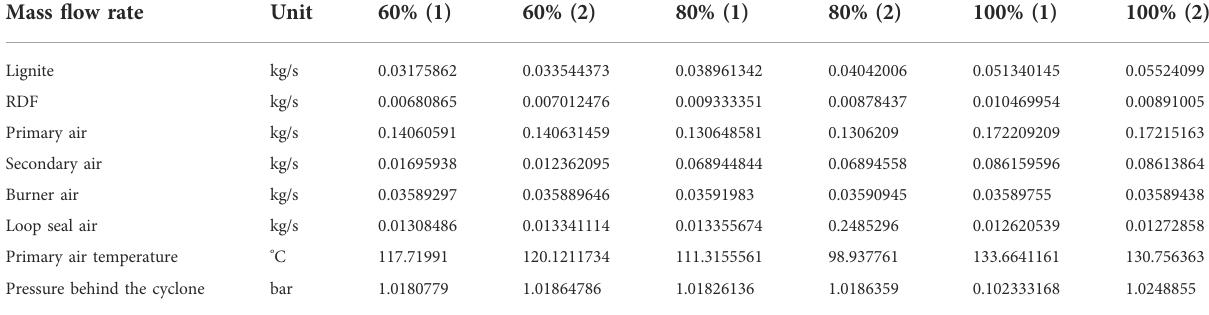
TABLE 4 Boundary conditions at different